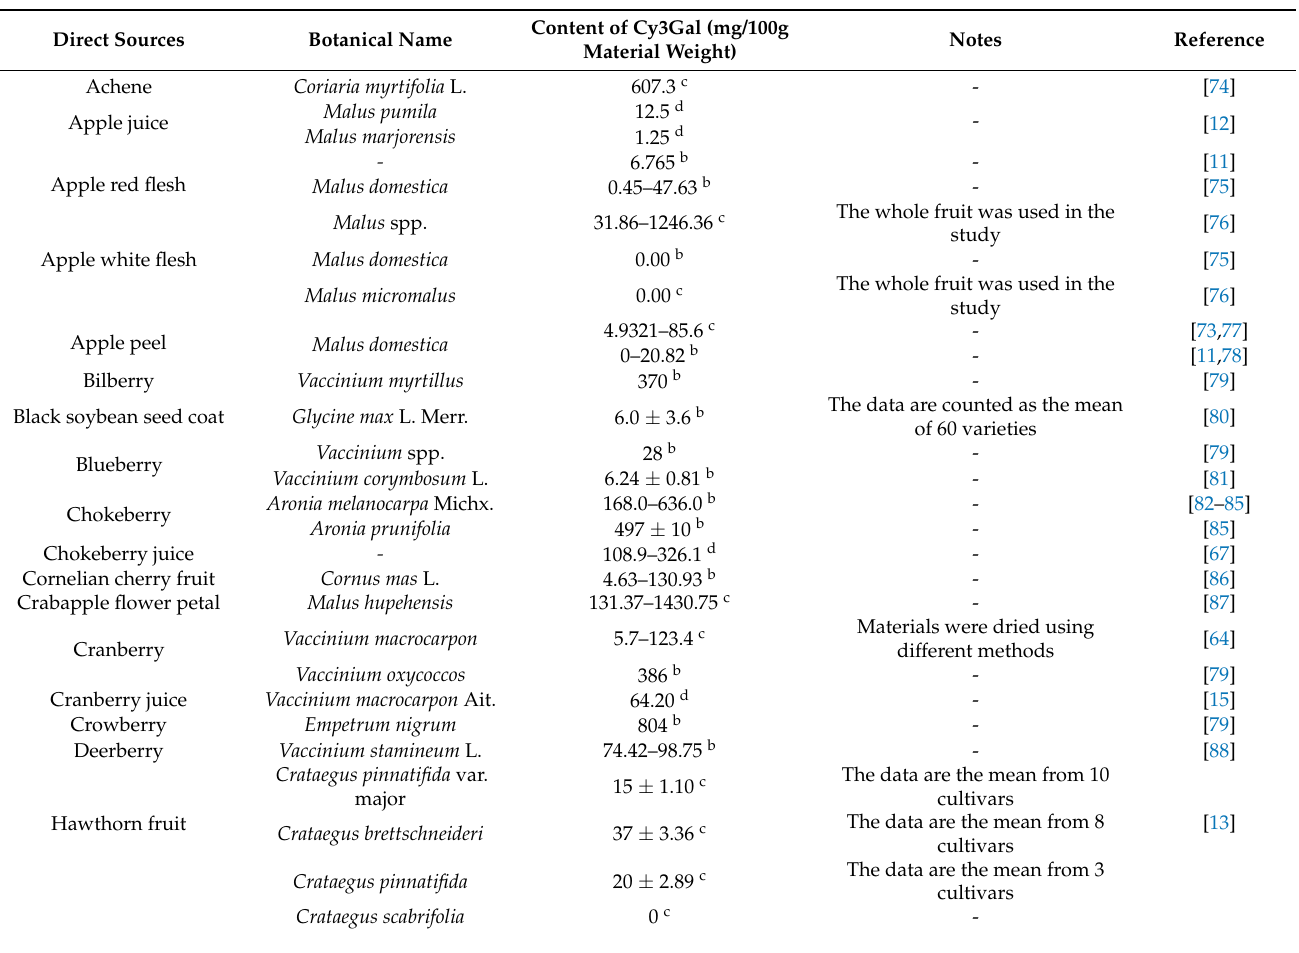
Table 1. Contents of Cy3Gal from different natural sources a